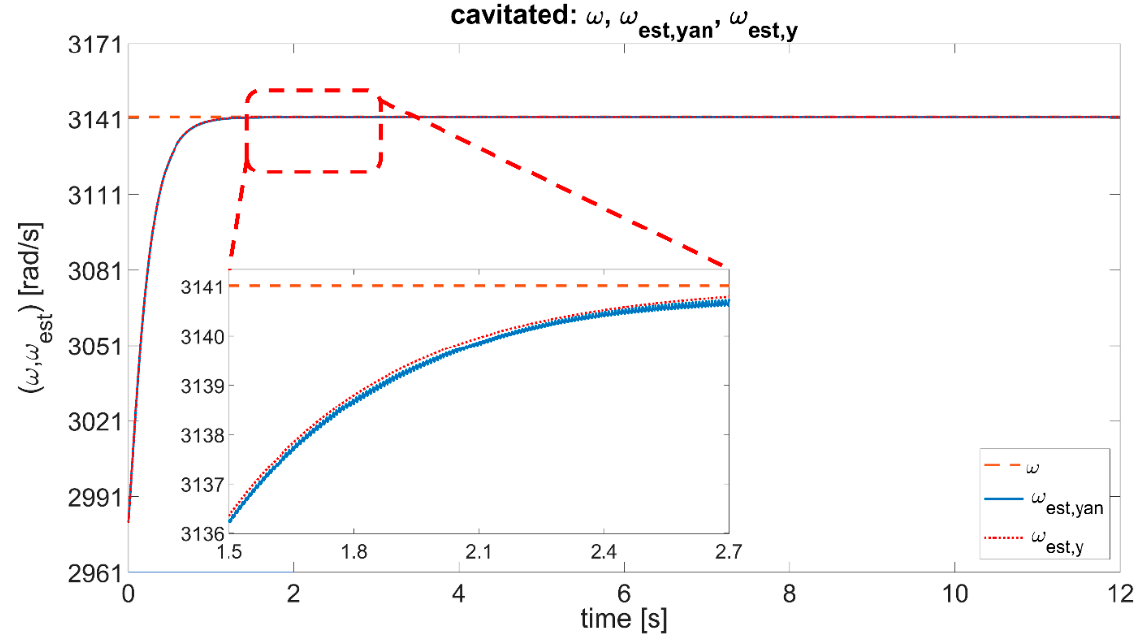
Figure 4. Frequency estimation performance in the case of cavitated condition.